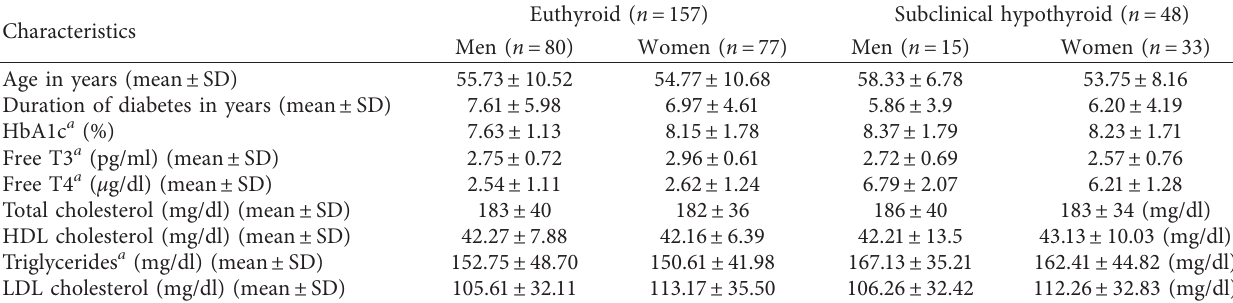
Table 1: Baseline characteristics of the euthyroid and subclinical hypothyroid type 2 DM patients. Characteristics